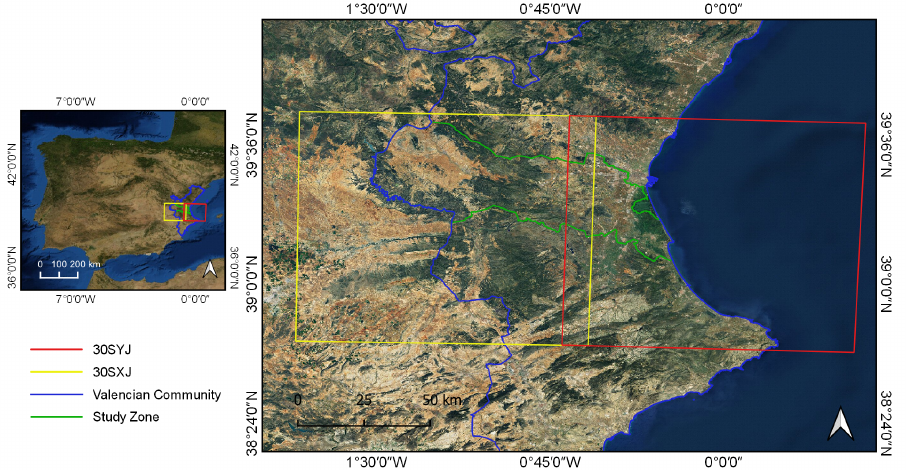
Figure 1. Location of the study area (green shape) in the Valencian Community (blue shape), East of Spain. The area is covered by two Sentinel-2 tiles, 30SYJ (red) and 30SXJ (yellow). Ground truth was provided by regional Valencian authorities (see Table 1). Two major classes of parcels were considered: active and abandoned, both of them containing